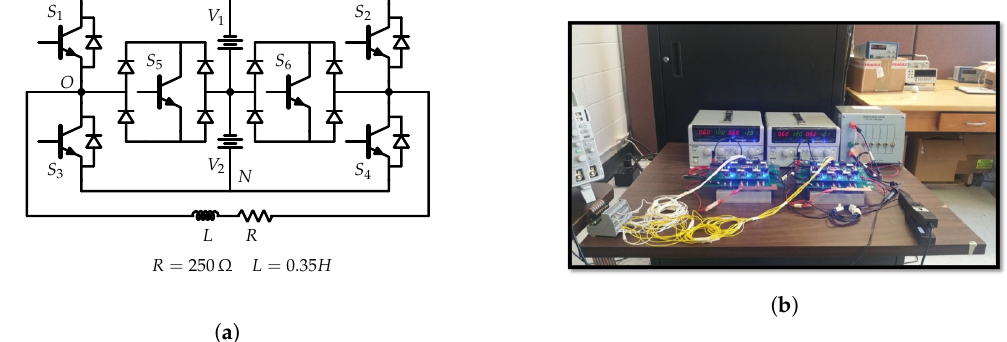
Figure 8. Experimental test setup: ( a ) circuit and ( b ) picture of the laboratory test